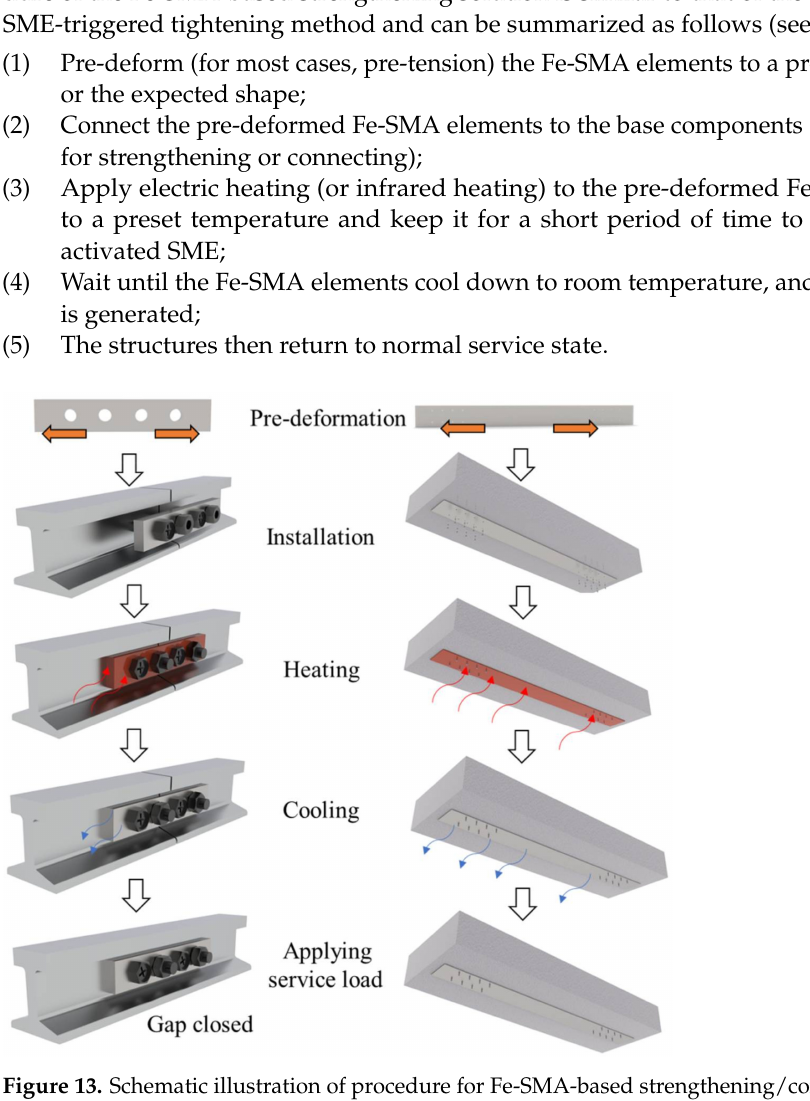
Figure 13. Schematic illustration of procedure for Fe-SMA-based strengthening/connecting